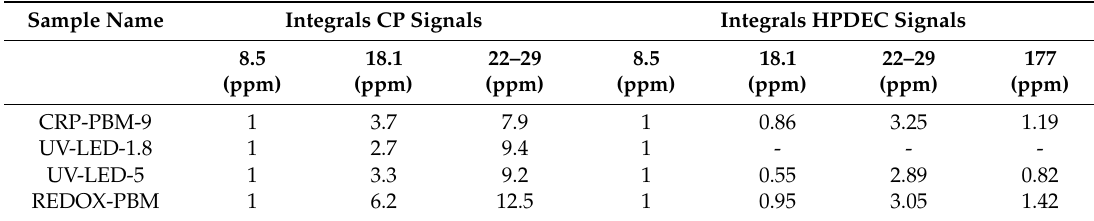
Table 3. Integrals of significant peaks in the 13 C MAS-NMR spectra shown in Figure